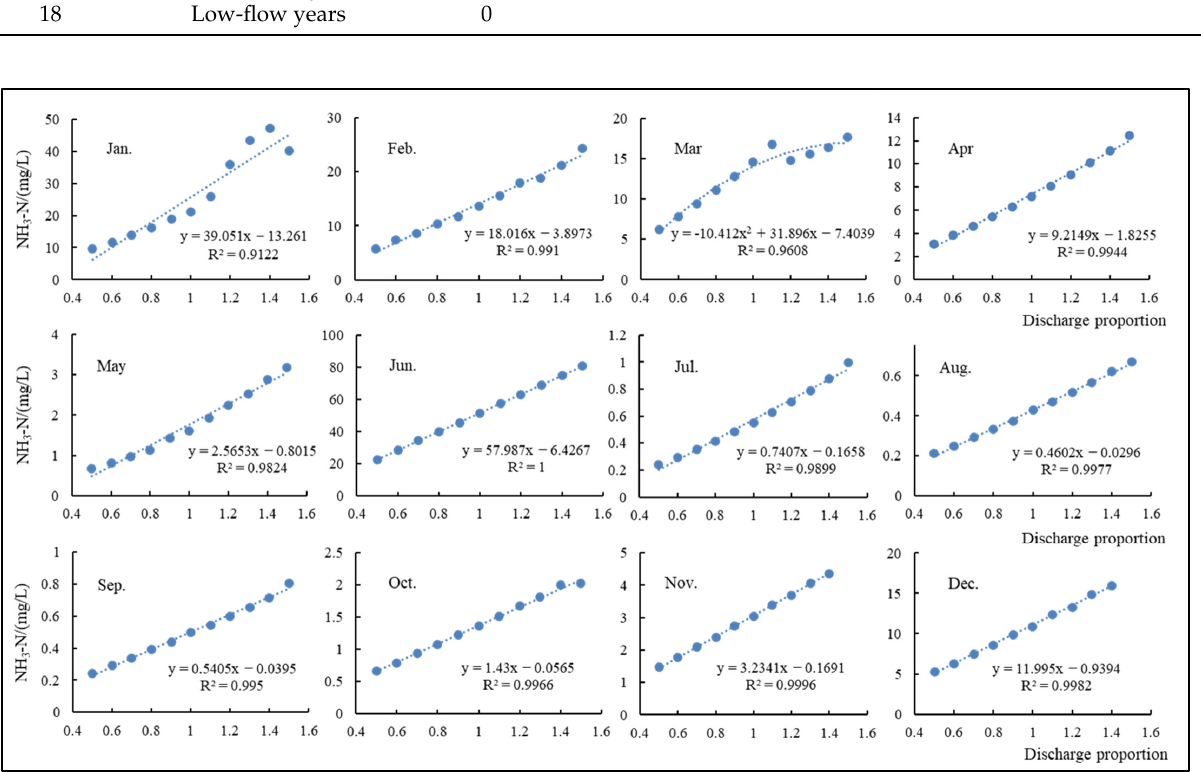
Figure 8. Relationship between the emission intensity of pollution source and NH 3 -N concentration in each month (taking the normal-flow year as an example).